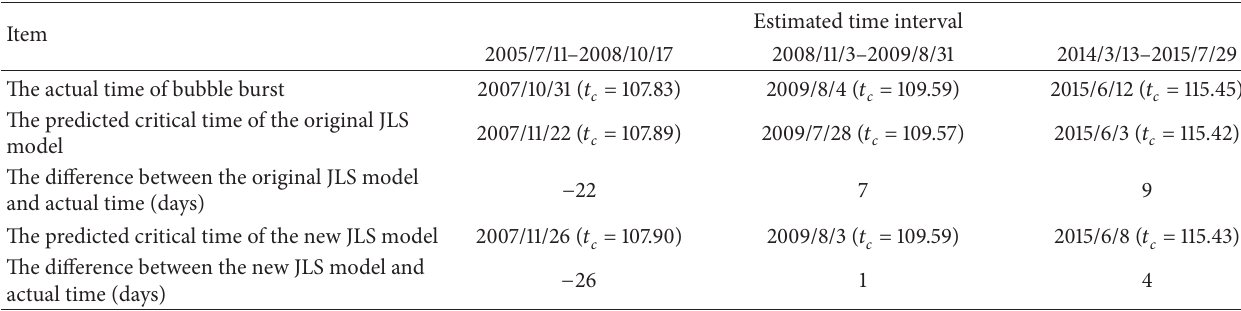
The predicted critical time of the original JLS The difference between the original JLS model and actual time (days) The predicted critical time of the new JLS model The difference between the new JLS model and actual time (days) Value in parentheses is the predicted critical time 𝑡 𝑐 . Table 2: Prediction of the critical time of the SZSC bubbles burst for both models and their differences with the actual times of bubble burst. Item The actual time of bubble burst